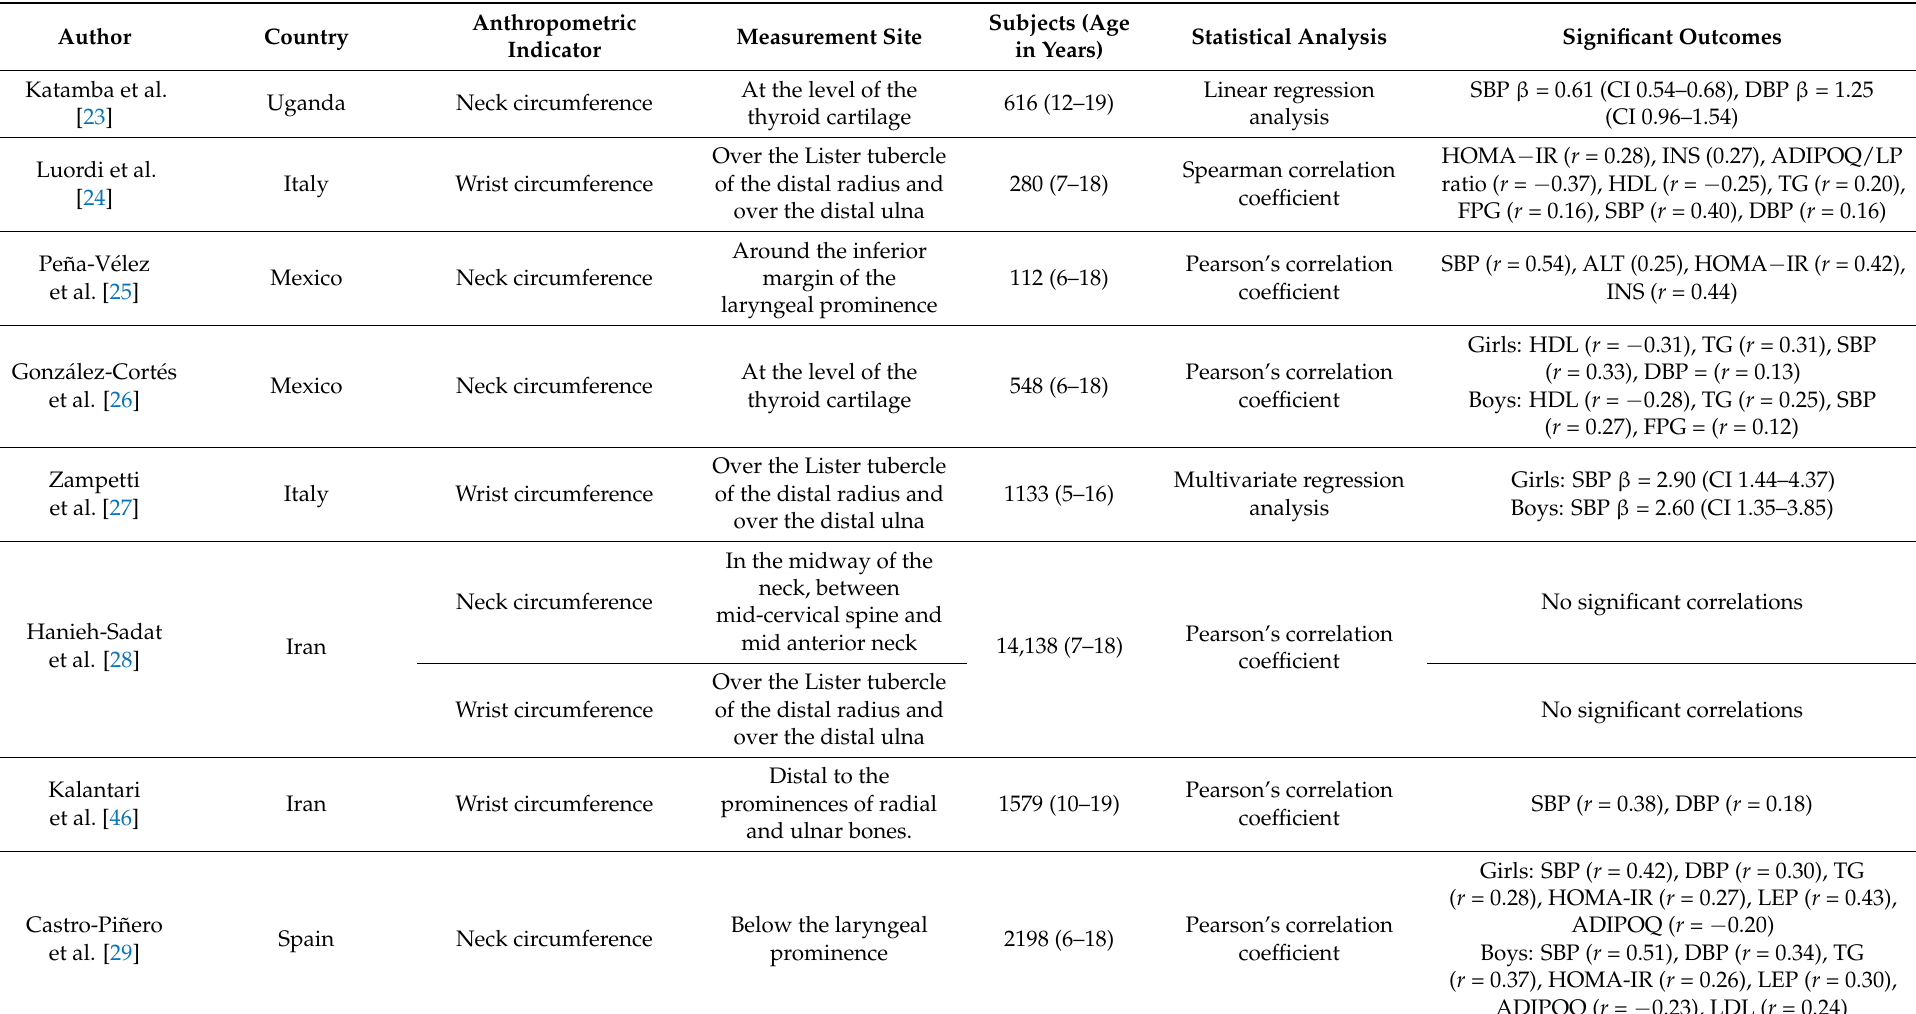
Table 3. Characteristics of included